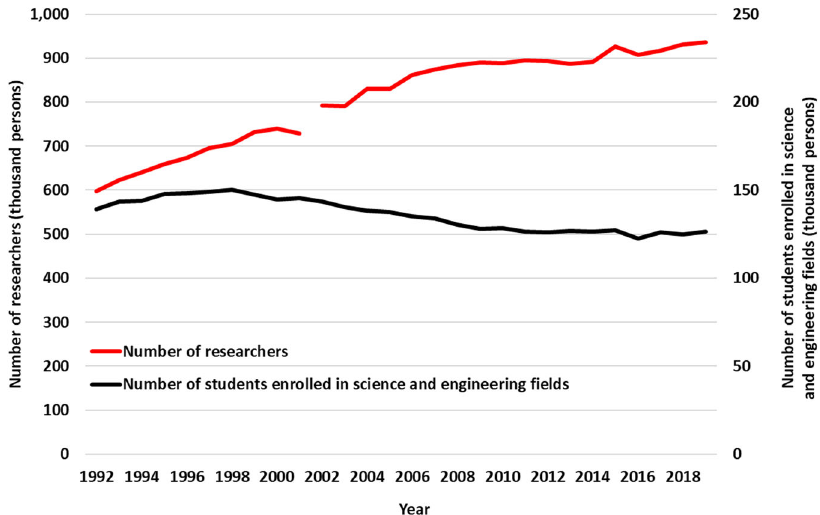
Fig. 2 Trends in R&D personnel. Regarding the number of researchers, the timing of the statistical survey differs between surveys conducted before 2001 (as of April 1) and those conducted after 2002 (as of March 31). Therefore, the graphs are not connected due to the continuity problem. Source: